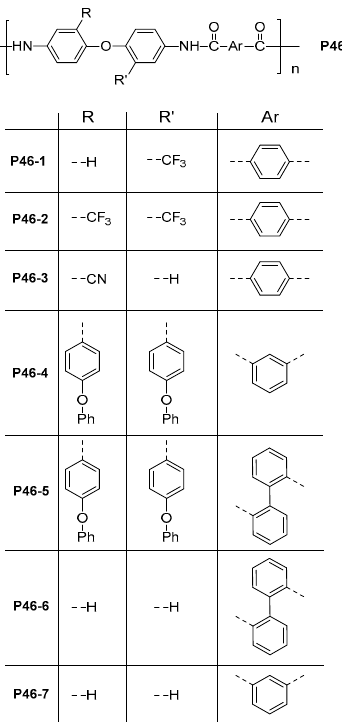
Scheme 23. Blue inherently colored aromatic copolyamides.